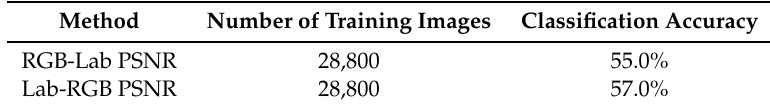
Table 4. Comparison of the classification accuracy by overlapping the inverse PSNR method about two color